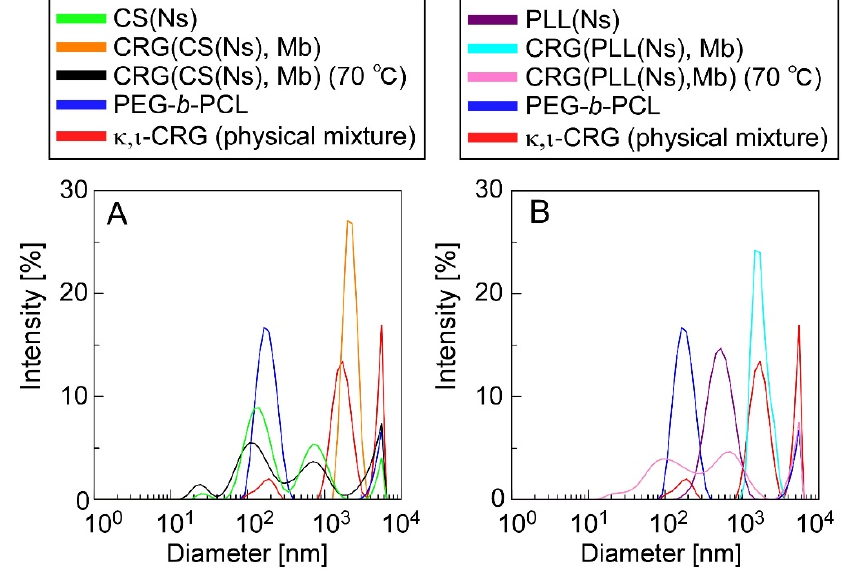
Figure 5. DLS-determined diameter distributions of ( A ) CRG(CS(Ns), Mb) and ( B ) CRG(PLL(Ns), Mb) microparticles. DLS data for CS (Ns) and PLL(Ns) nanoparticles, PEG- b -PCL, and a κ , ι -CRG (physical mixture of κ -CRG and ι -CRG) are also shown for comparison.